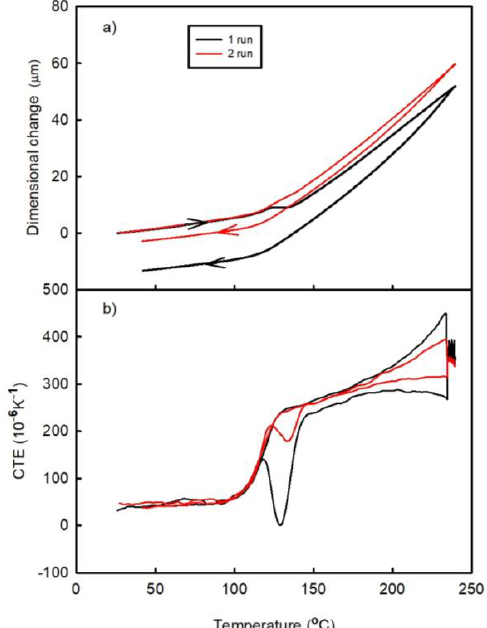
Figure 4. Temperature dependences of the ( a ) dimensional changes and ( b ) CTE of the A2 sample (FR4 laminate passed through the oven) observed after two runs.